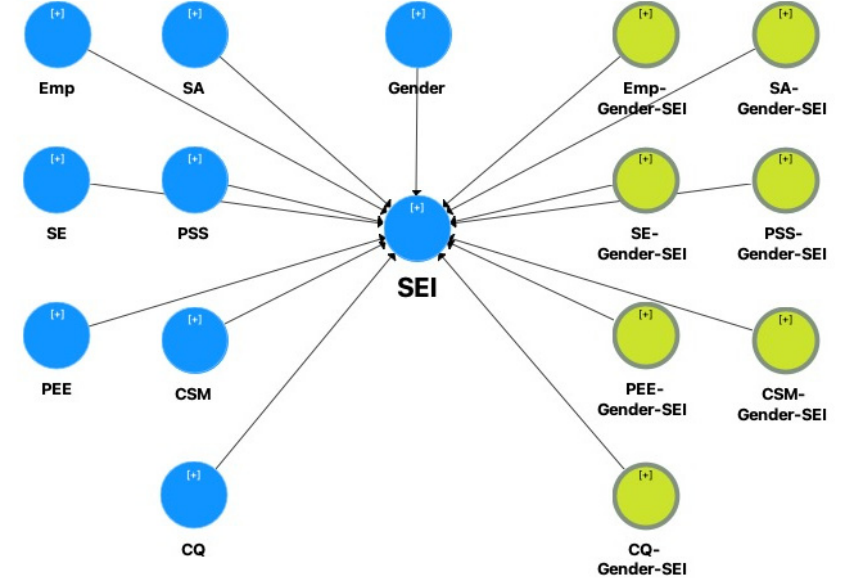
Figure 2 . Structural model . Figure 2. Structural